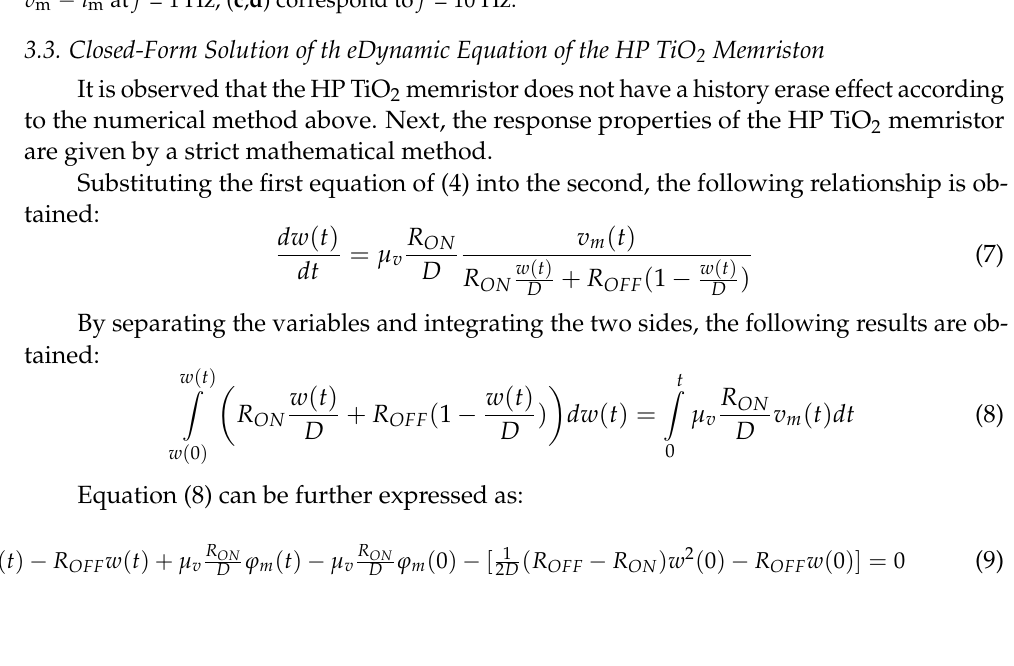
Figure 4. v m ( t ) = V 0 sin ( 2 π ft ) is used as the excitation signal, where V 0 = 0.5 V. ( a ) corresponds to f = 1 Hz, equivalent to the excitation under quasistatic conditions; ( b ) corresponds to the locus of v m − i m at f = 1 Hz; ( c , d ) correspond to f = 10